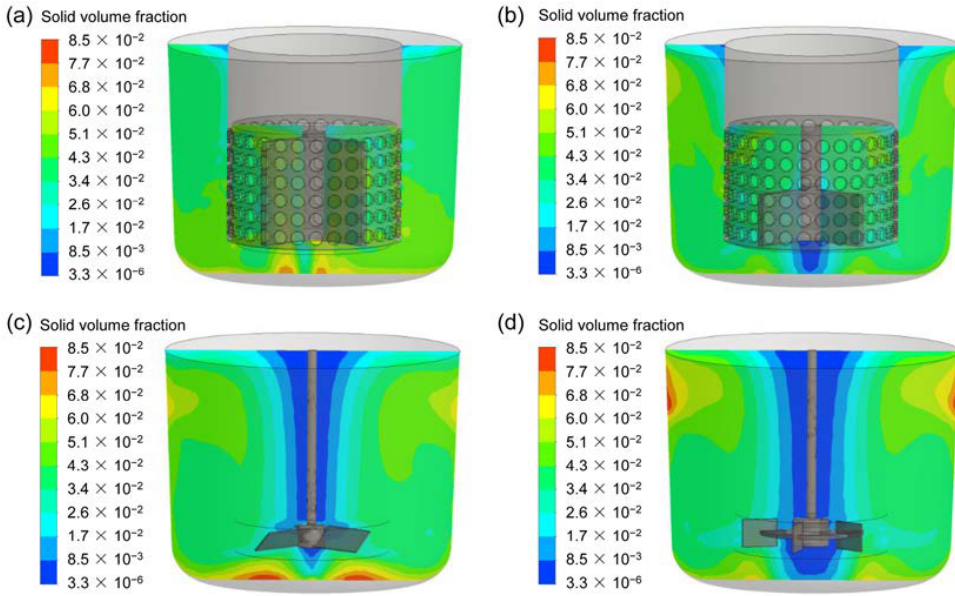
Figure 11. The distribution of solid volume fraction at the vertical plane for the four types of agitators at the stirring speed of 400 rpm; ( a ) CSRS agitator; ( b ) HCSRS agitator; ( c ) A200 agitator; ( d ) Rushton agitator.